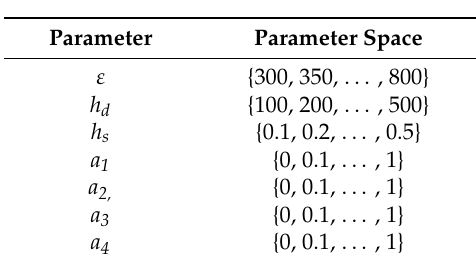
Table 1. Parameters